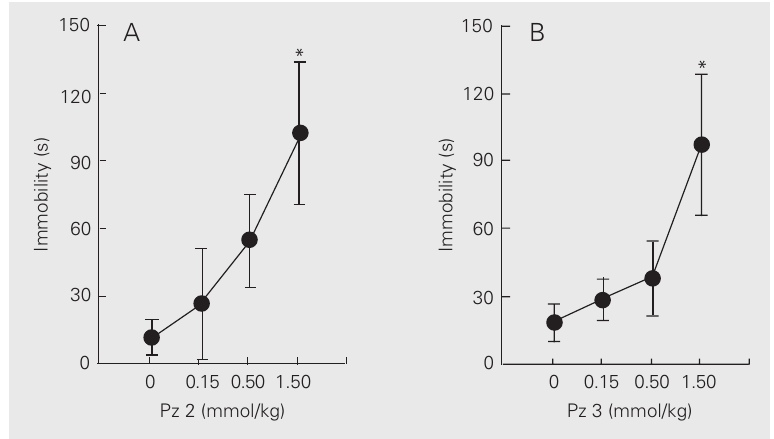
Figure 3. Effects of Pz 2 (A) and Pz 3 (B) on time spent immobilized (immobility) in the open field. Data are reported as means ± SEM for N = 8 animals per group. *P < 0.05 compared with vehicle group (Student-Newman-Keuls test).